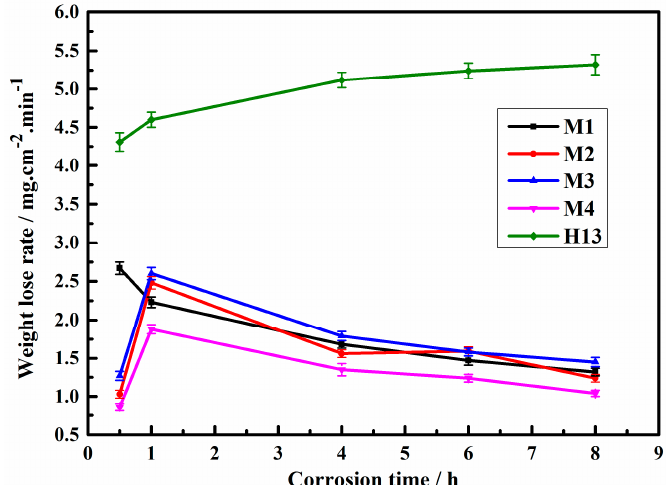
Figure 5. Weight loss per square centimeter of the samples per minute in molten aluminum at 750 °C for different corrosion times.